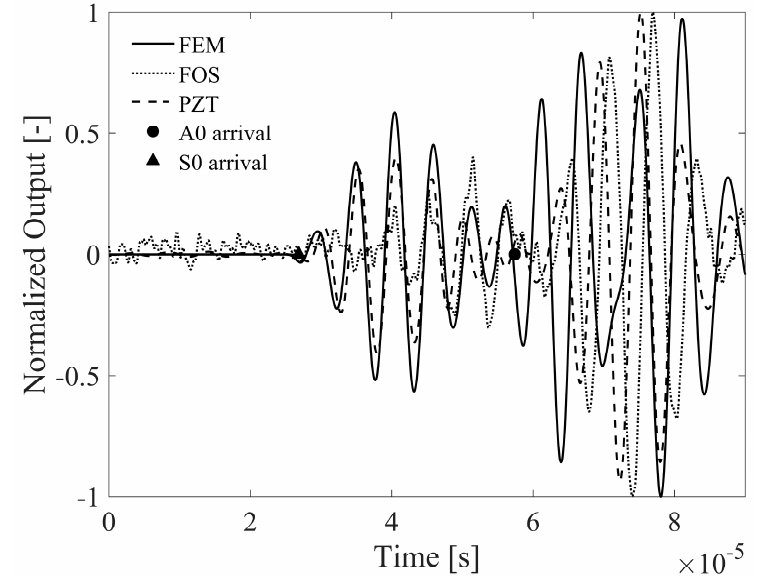
Figure 11. Comparison of FOC and PZT sensors vs. FEM simulated signals at 175 kHz Lamb wave frequency. The analytical ToA for A0 and S0 modes is also reported as reference.